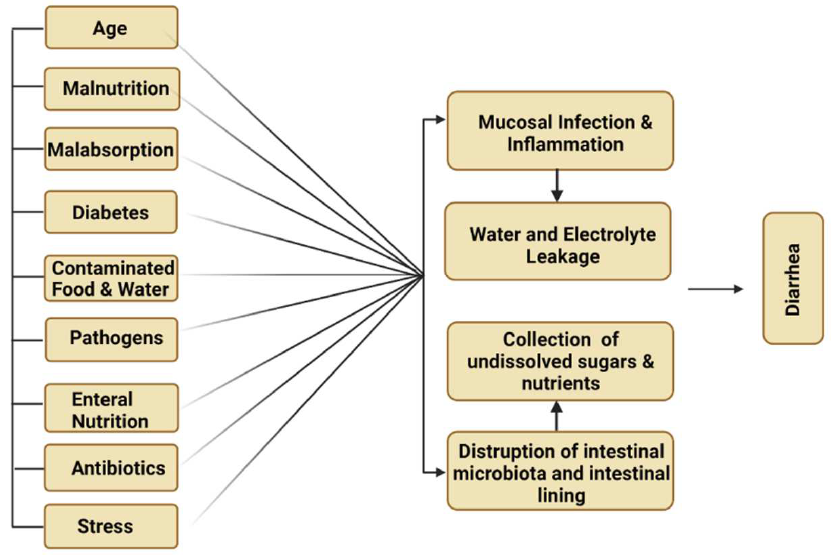
Figure 5. Major causes of diarrhea.